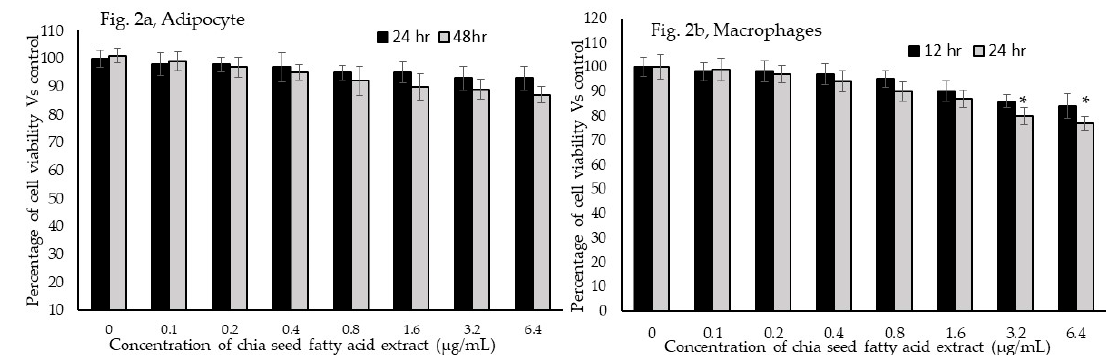
Figure 2. In vitro cytotoxic e ff ect of chia seed extract on ( a ) human adipocyte (24 h and 48 h) and ( b ) macrophages (12 h and 24 h). Data are presented as the mean ± standard deviation (SD) ( n = 6 in all the groups). * p < 0.05 vs. control.